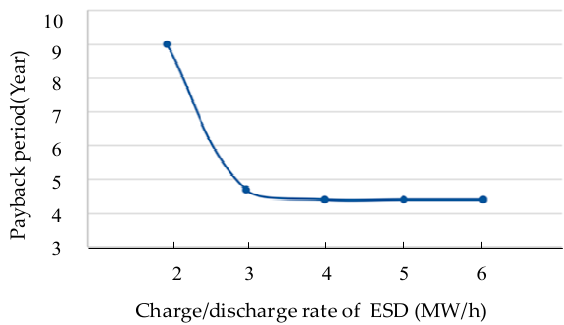
/ discharge rate of the ESD. Energies 2019 , 12 , x FOR PEER REVIEW